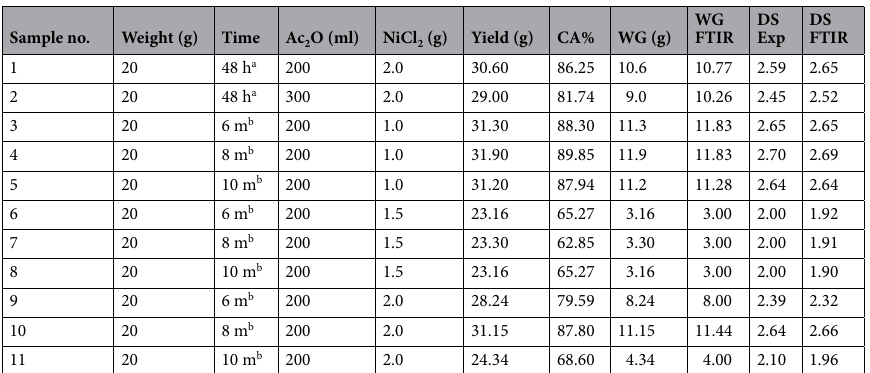
Table 1. Demonstrate conditions and yield of the acetylation of cellulose extracted from cotton Giza 86. a Conventional method. b Microwave irradiation method. h hour, m min.